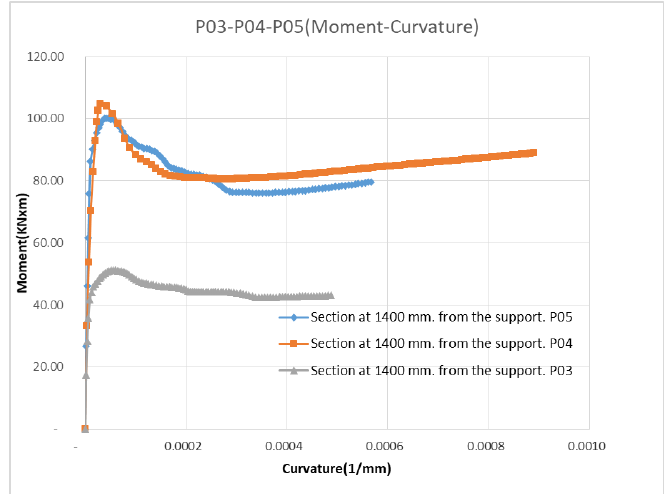
Figure 30. Moment – curvature graph of P03, P04, and P05. Figure 30. Moment–curvature graph of P03, P04, and